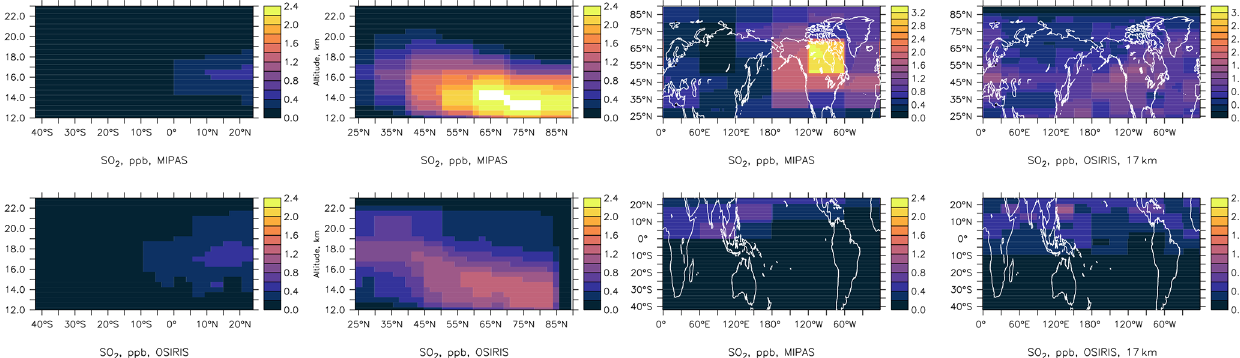
Figure B3. 2009 Sarychev (second column, upper right row) and Manda Hararo (first column, lower right row) eruptions: SO 2 mixing ratio perturbation (ppb) derived from MIPAS and OSIRIS; arrangement of the panels because the event is split at 24 ◦ N as for integrated values in Table 2. MIPAS data 18 June to 18 July 2009, OSIRIS data 17 July to 3 August. Zonal average vertical distribution (left) and plumes at 17km altitude